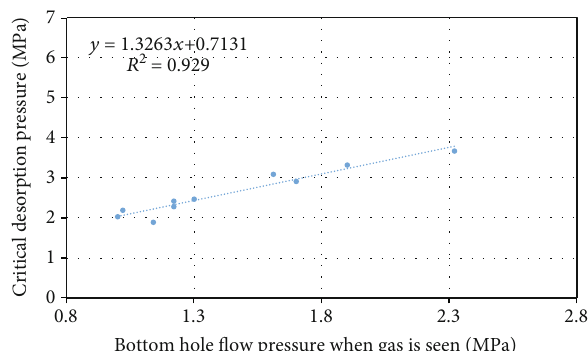
Figure 9: Relationship between critical desorption pressure and bottom hole pressure at begin of gas fl ow.